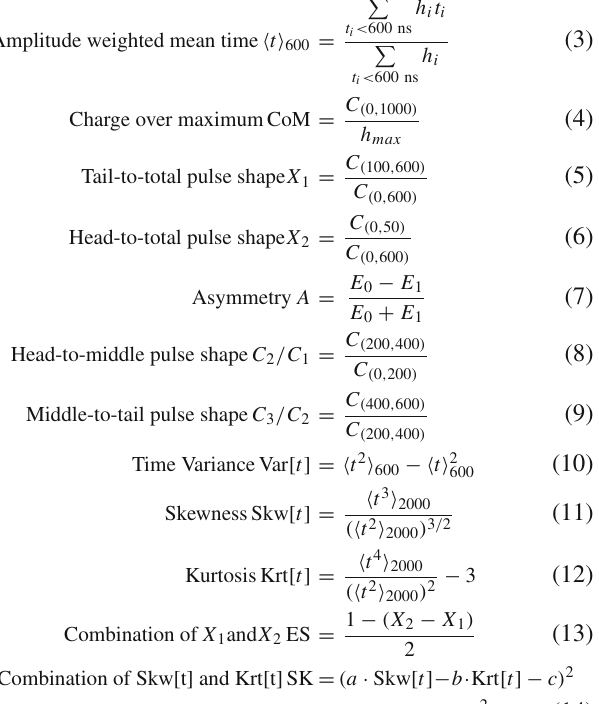
Table 2 Upper limit on the activity of Tellurium cosmogenic isotopes in the NaI-33 crystal, at the time of the crystal arrival underground. For each isotope we indicate the energy of the gamma emission whose ± 3 σ interval in the spectrum was used to extract the activity limit Isotope γ line [keV] Limit [mBq/kg] 127m Te 88.3 0.14 125m Te 144.8 0.10 123m Te 247.6 0.09 121m Te 294.0